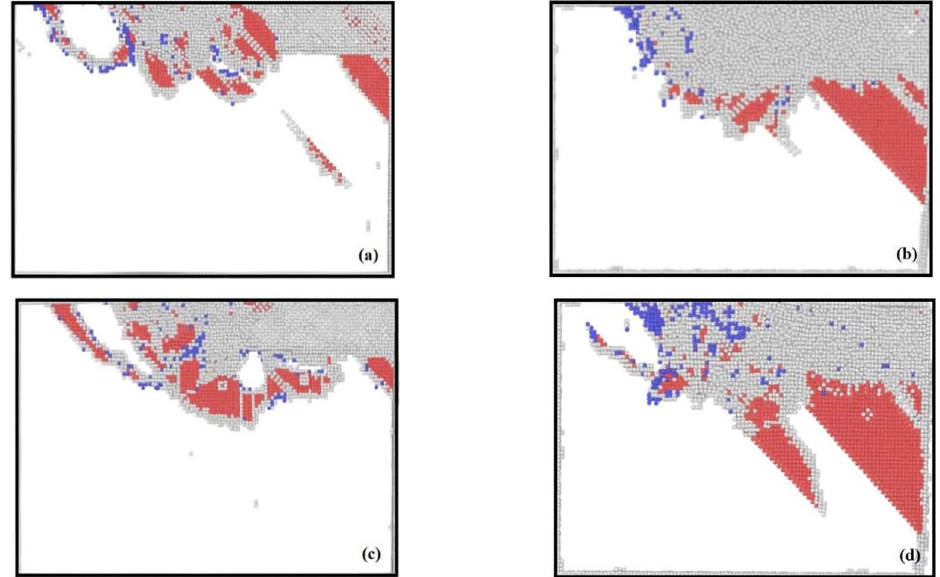
Figure 14. Distribution of subsurface defects at different cutting speeds (( a ) cutting speed is 100 m/s and without watermedium ( b ) cutting speed is 100 m/s and with watermedium ( c ) cutting speed is 100 m/s and without watermedium ( d ) cutting speed is 200 m/s and with watermedium).